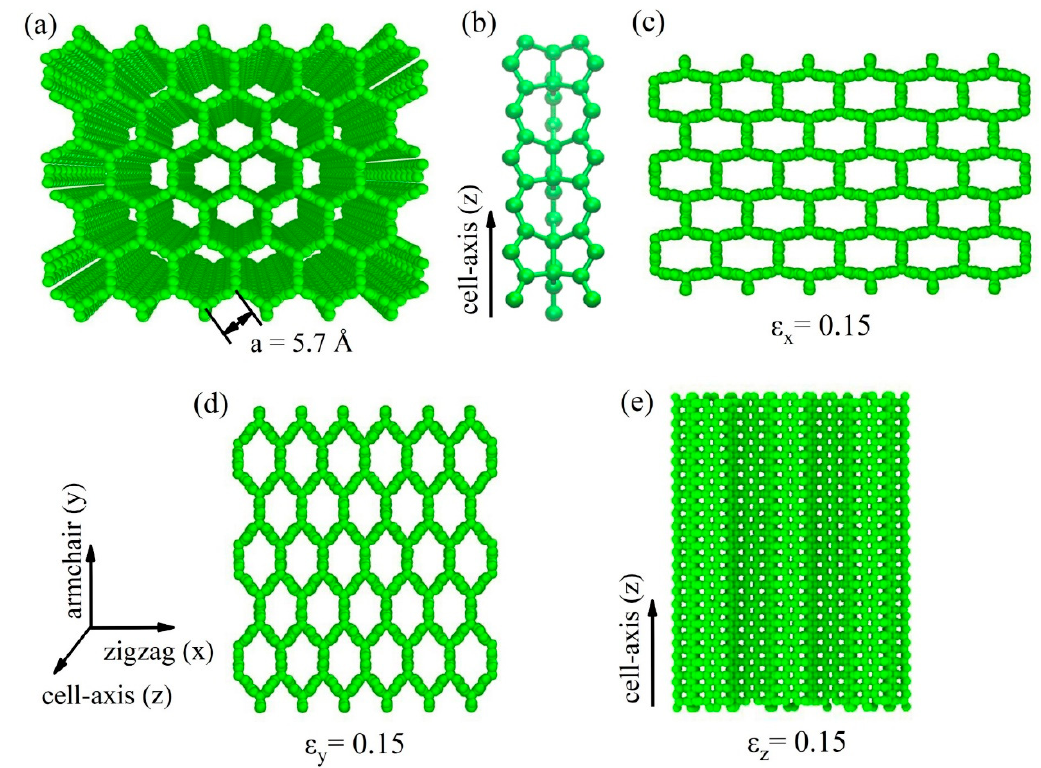
Figure 1. Stable carbon honeycomb structure. ( a ) Atomistic structure of carbon honeycomb. ( b ) Local atomic structure at the 5-5-8 junction of carbon honeycomb. ( c – e ) Snapshots of carbon honeycomb at 0.15 tensile strain along x, y, and z directions, respectively.